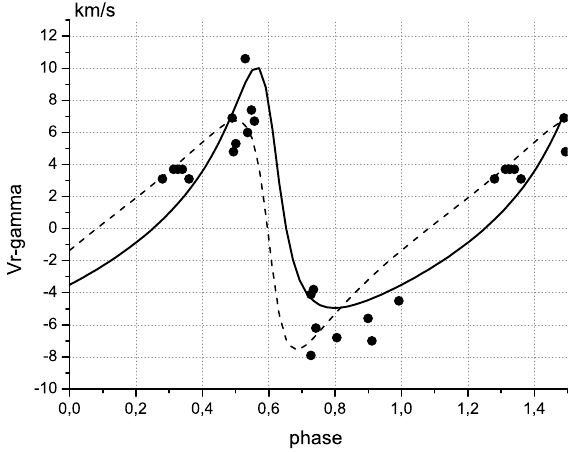
Fig. 4. ADS 9173. Comparison of the astrometric orbit Bab (solid line) with the spectroscopic orbit (dash line) and radial velocity observations (black